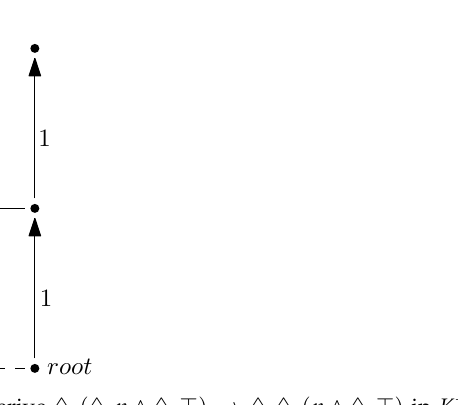
+ com + com + Γ + Γ 2 we first 12 21 1 2